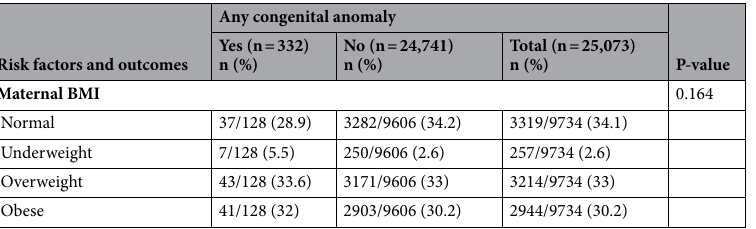
Table 1. Neonatal & maternal socio-demographic factors of study population (N; %, the dominator number is indicated when there is missing data). GDM gestational diabetes mellitus, PGDM pregestational diabetes mellitus. † Missing data for: nationality (n = 4), parity (n = 4), consanguinity (n = 16,597), maternal